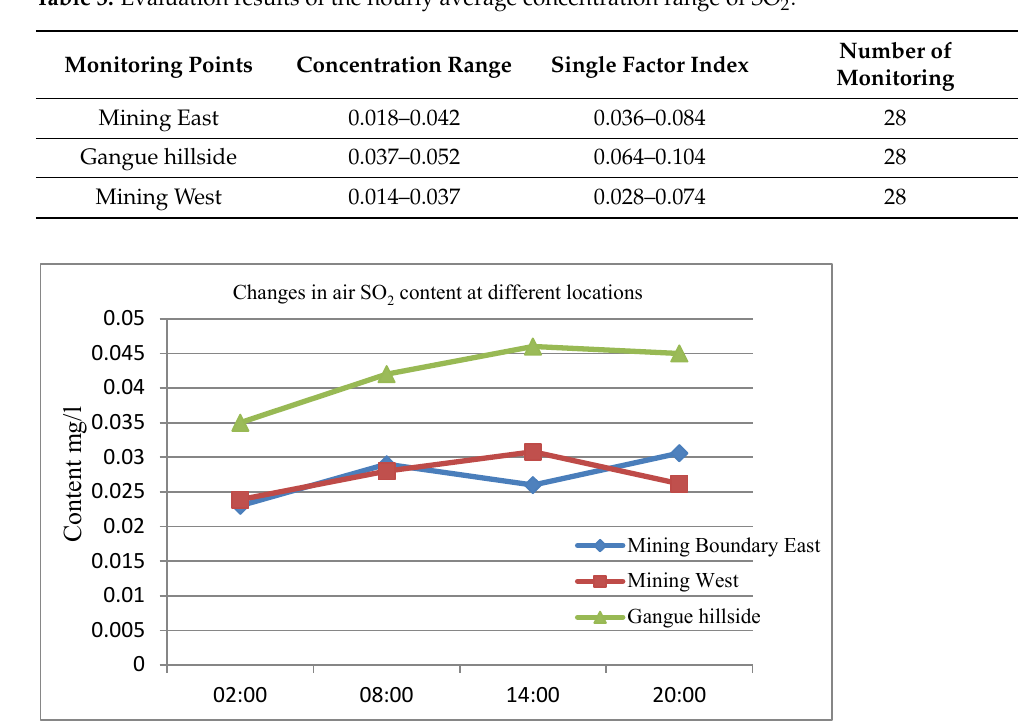
Figure 2. Changes in air SO 2 content at different locations.